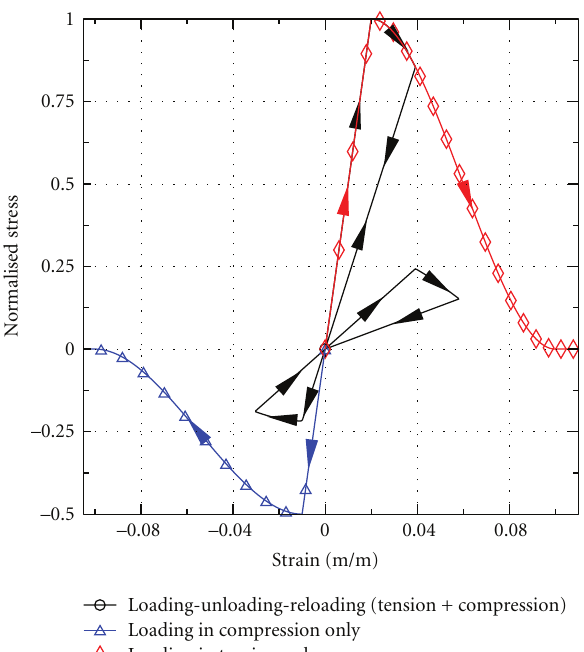
Figure 9: Element loaded-unloaded-reloaded in tension and compression in the fibre direction.